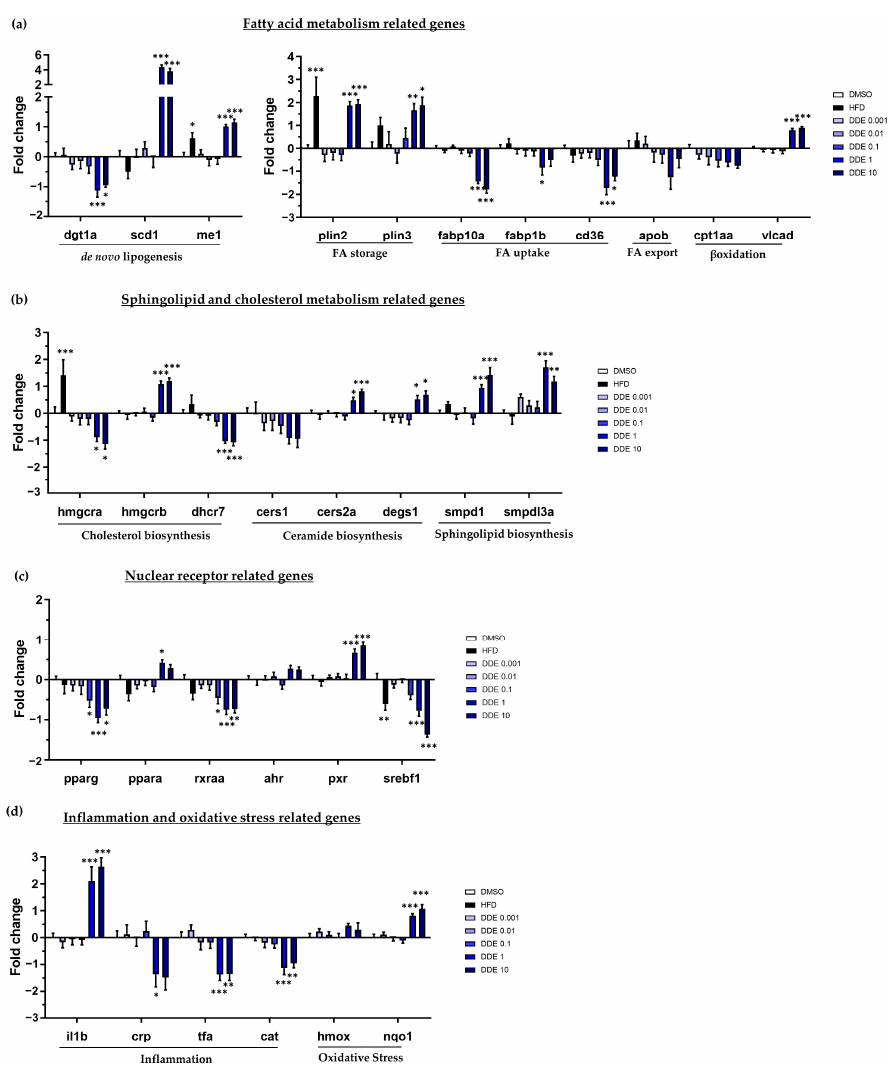
Figure 6. Impact of HFD and DDE on mRNA expression of several genes involved in lipid metabolism characteristic of steatosis and in toxicity. mRNA expression was evaluated by RT-qPCR gene expression analysis by using the microfluidic Fluidigm-Biomark technology. Zebrafish larvae were exposed to HFD or DDE (from 1 nM to 10 µM) during 48 h, from 3 to 5 dpf. mRNA expressions of genes related to fatty acid metabolism ( a ), sphingolipid and cholesterol metabolism ( b ), nuclear receptors, ( c ) and inflammation and oxidative stress ( d ), are shown. Data are expressed relative to mRNA levels measured in DMSO control larvae, set at 0 (log 2 fold change). Values are the mean ± SEM ( n ≥ 8). * p < 0.05, ** p < 0.01, *** p < 0.001, by comparison with control group using ANOVA and Dunnett’s test.